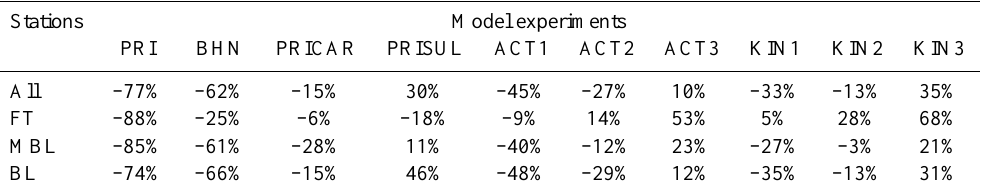
Table 3. Normalised mean bias between observed and simulated CN concentrations. Model experiments are described in Table 1, locations and time periods of the observations are shown in Table 2. Stations Model experiments PRI BHN PRICAR